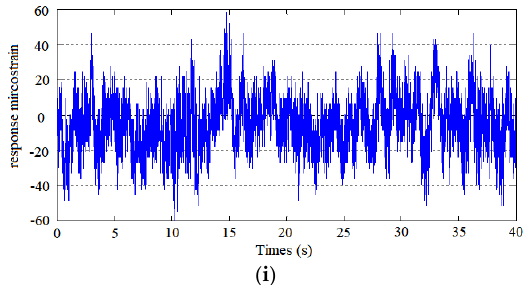
Figure 6. Response microstrain curves of the three risers at z = 0.5 m with a 5 N top tension force and